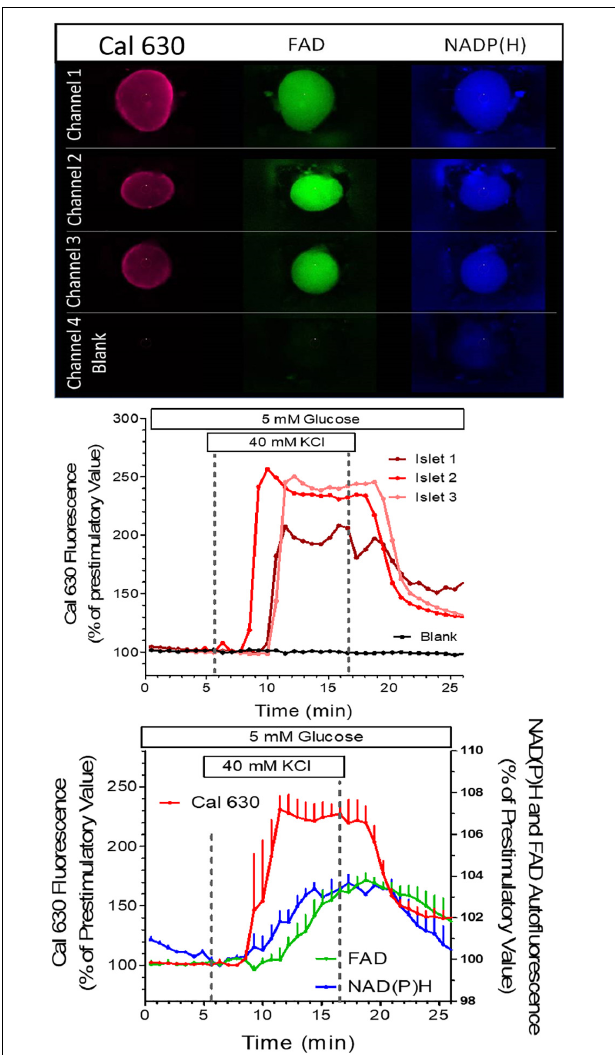
FIGURE 7 | Simultaneous measurement in perifused islets of the NAD(P)H autofluorescence, the FAD autofluorescence and the fluorescence of the Ca 2 + indicator Cal 630. Three islets of different size were loaded with Cal 630 AM, placed in wells, one each per well, and perifused with KR medium. A fourth well was left empty to provide a background signal. The wells were sequentially scanned, each islet being excited with three wavelengths to generate the dark blue NAD(P) H-, the green FAD-, and the red Cal 630 fluorescence. In the blank well a slight blue fluorescence was visible by cellular debris from a preceding experiment (upper panel). From 6 to 16 min the perifusion was switched to a medium containing 40 mM KCl. The intensity was normalized to the values at 6 min. The single traces of the Cal 630 fluorescence are shown in the middle graph, the mean values ± SEM of all three fluorescences are shown in the lower graph. Note the lack of fluorescence increase in the blank well and the increase of both NAD(P)H- and FAD-fluorescence during KCl